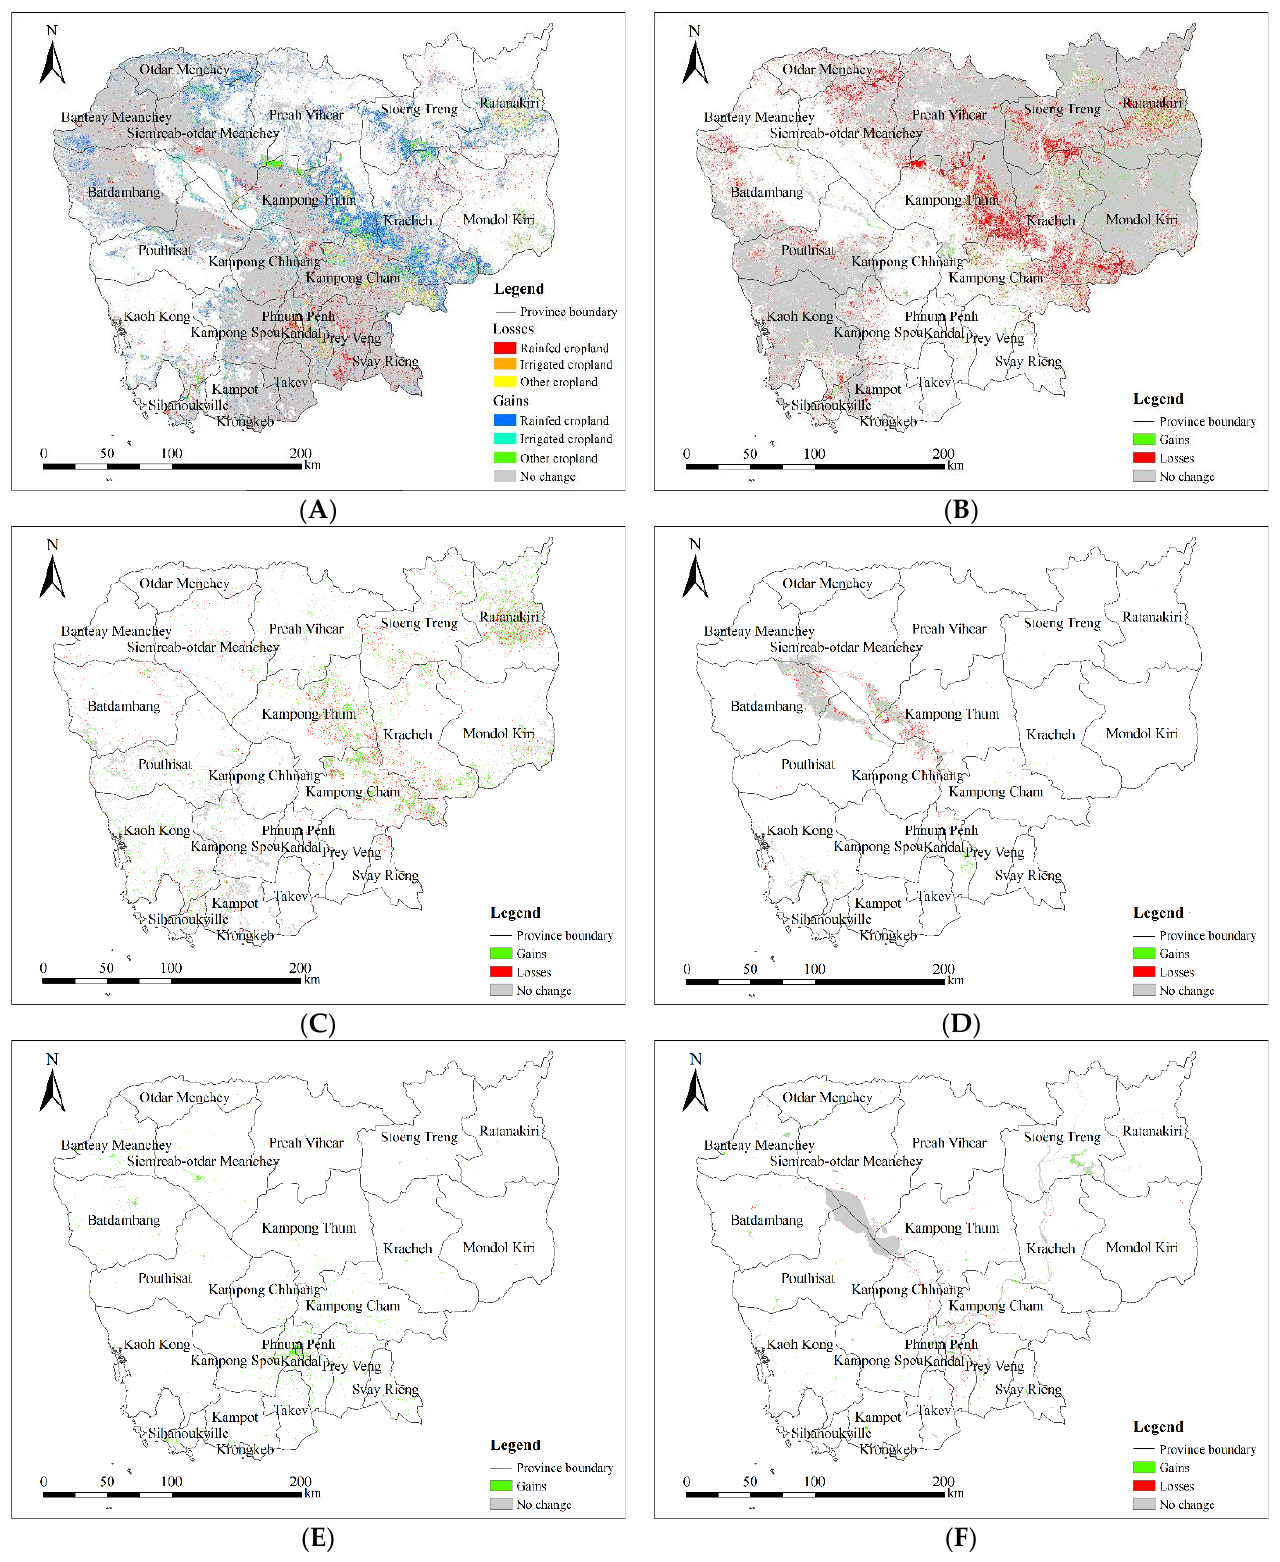
Figure 5. Spatial distributions of different LUC gains/losses during 2000 – 2020. ( A ) Cropland; ( B ) forest; ( C ), shrubland; ( D ) wetland; ( E ) impervious; ( F ) water. The shrubland area showed an increasing trend with a dynamic degree of 0.29%. There was a decrease in the shrubland area of 1.54 × 10 3 km 2 , mainly due to conversion